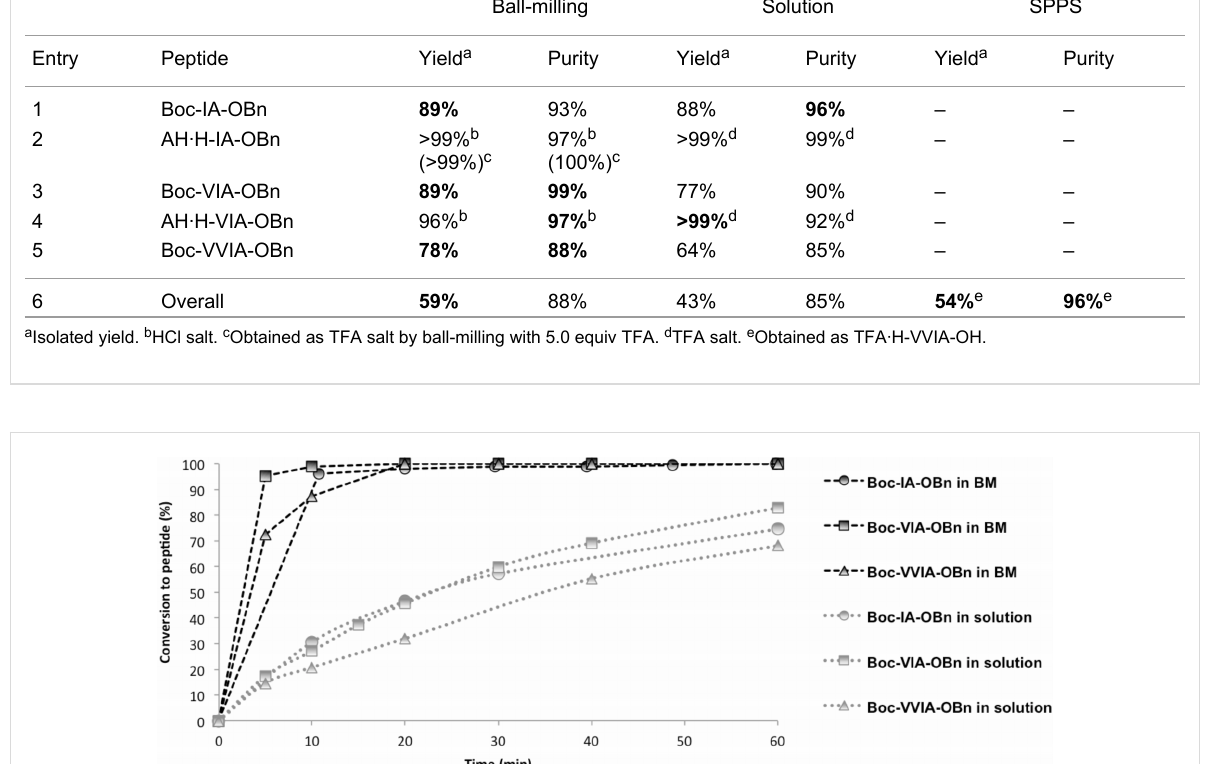
Table 1: Yields and purities for the three strategies (for each entry, the best result is indicated in bold). Ball-milling Solution SPPS